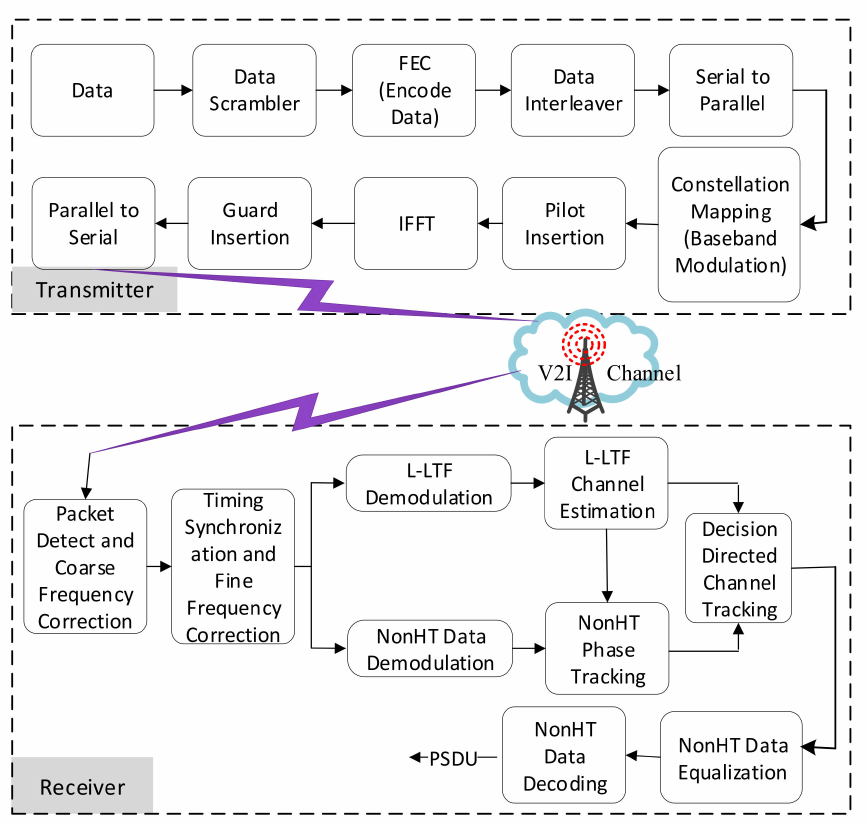
Figure 2. Transmitter and receiver design of IEEE 802.11p for V2I